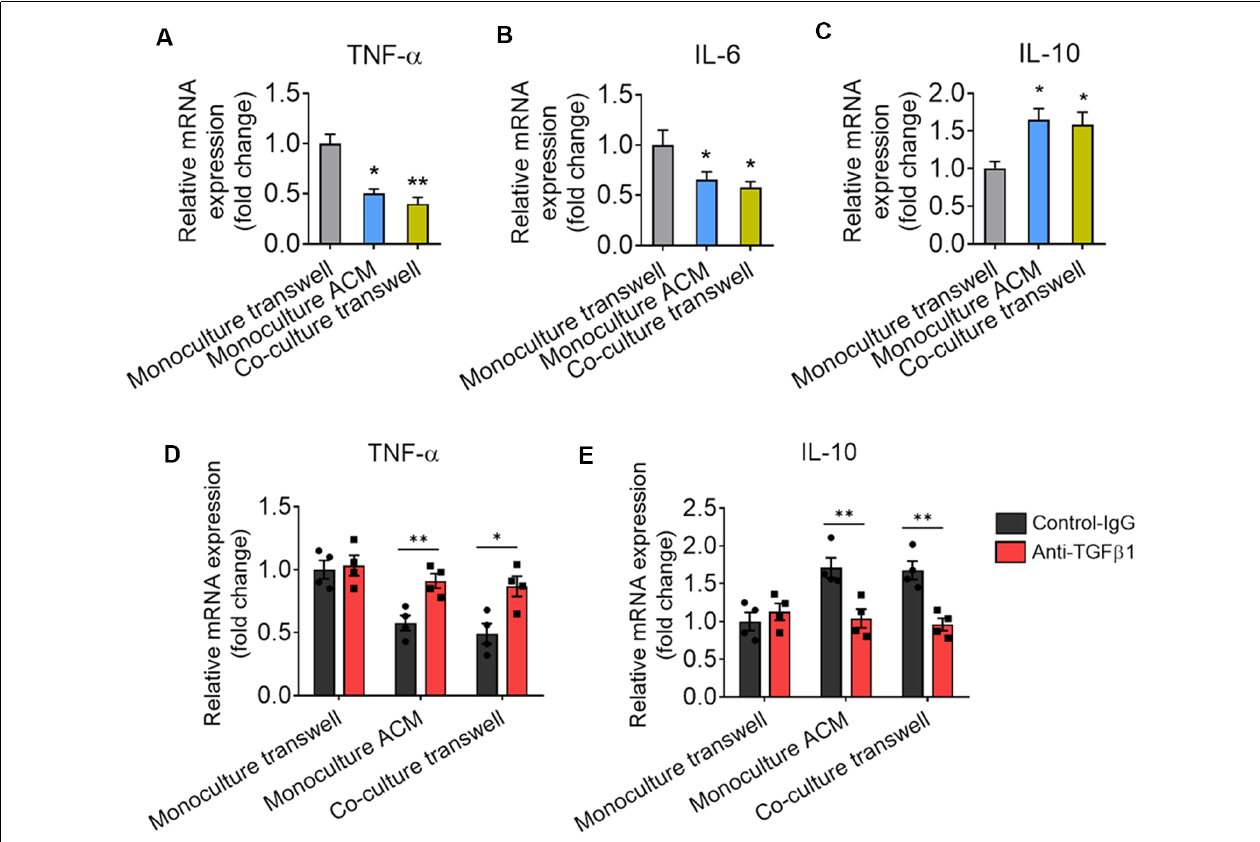
FIGURE 8 | Astrocytes produce TGF- β that suppresses to microglia-mediated inflammatory response. (A–C) mRNA expression of TNF- α , IL-6, and IL-10 in microglia cultured alone, cocultured with astrocyte by transwell and cultured by ACM. Results of each group were obtained from four independent samples. Each sample is made in triplicate. ( D,E ) mRNA expression of TNF- α and IL-10 in microglia cultured alone, cocultured with astrocyte by transwell and cultured by ACM in the presence or absence of the anti-TGF- β antibody. Data are presented as mean ± SEM, * P < 0.05, ** P < 0.01 (unpaired two-tailed Student’s t -tests, one-way or two-way ANOVAs, followed by Tukey’s multiple-comparison test, where